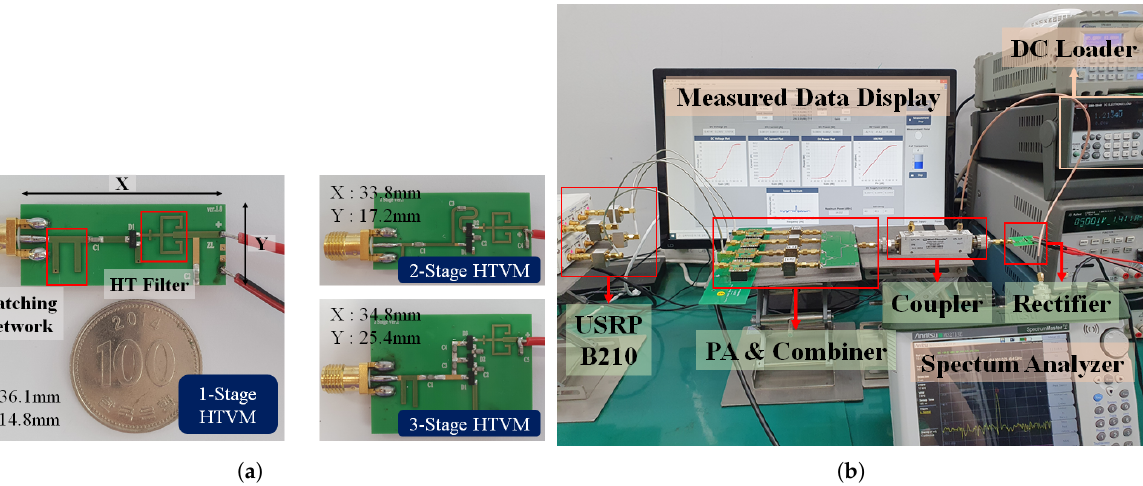
Figure 9. Measurement set-up and fabricated N-stage HTVM (N = 1,2,3); ( a ) fabricated N-Stage HTVM and ( b ) measure- ment